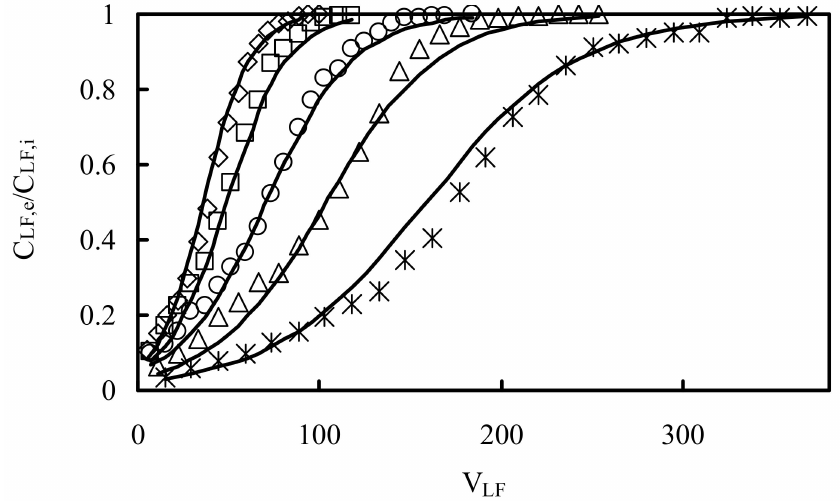
Figure 3. Breakthrough curves for the solution containing M-PVAC-IDA using HGM separator (HGF-10 1) at various C LF , i with Q LF = 0.833 L min − 1 ( v 0 = 1.731 m min − 1 ).